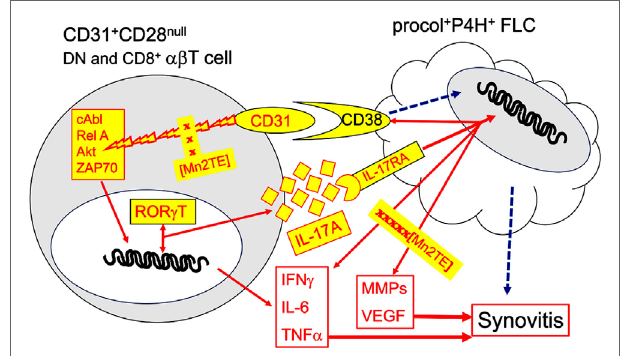
FigUre 10 | Model for an inflammatory circuit between CD31 + CD28 null αβ T cells and FLC in JIA synovitis. The present data ( Figures 2 and 7 ) authenticate enrichment of CD31 + CD28 null DN αβ T cells, as well as procollagen [procol] + proline hydroxylase [P4H] + FLC in SF of oligoarticular and rheumatoid factor − polyarticular JIA. In previous work, we have shown a similar CD31 + CD28 null subset in the CD8 + compartment (7). Ligation of CD31 with specific antibody on these two αβ T cell subsets sufficiently and effectively signals phosphorylation of ZAP70, Akt, cAbl, and RelA ( Figure 4 ). It is also sufficient to induce production of IL-17A, IL-6, IFN γ , and TNF α ( Figure 3 ). These four cytokines are among the most dominant cytokines identified in SF ( Figure 1 ). We have shown previously that similar cytokine production is achieved by CD31 ligation with CD38-Ig (7), indicating CD38 is a true ligand, CD31 ligand on synovial CD31 + αβ T cells. Relevance of CD31 as a driver IL-17A is indicated by the specific trans -activation of IL-17A promoter and induction ROR γ T ( Figure 6 ). CD31- driven production of cytokines and phosphorylation of cAbl and RelA are sensitive to down regulation by Imatinib, a known cAbl inhibitor, and by MnT2E, a superoxide mimic, and inhibitor of the DNA-binding activity of NF κ B ( Figure 5 ). IL-17RA + CD38 + FLC is a likely target of IL-17A as indicated by the upregulation of CD38 ( Figure 7 ). Futhermore, IL-17A induces FLC to produce additional inflammatory cytokines/chemokines and tissue-destructive effectors, which are sensitive to down modulation by MnT2E ( Figures 8 and 9 ). Such inhibitory activity of MnT2E on FLC is comparable, and in some cases, better than the biologics IL6i and TNFi. Details of IL-17A and CD38 signaling in FLC [dashed arrows] remain to be